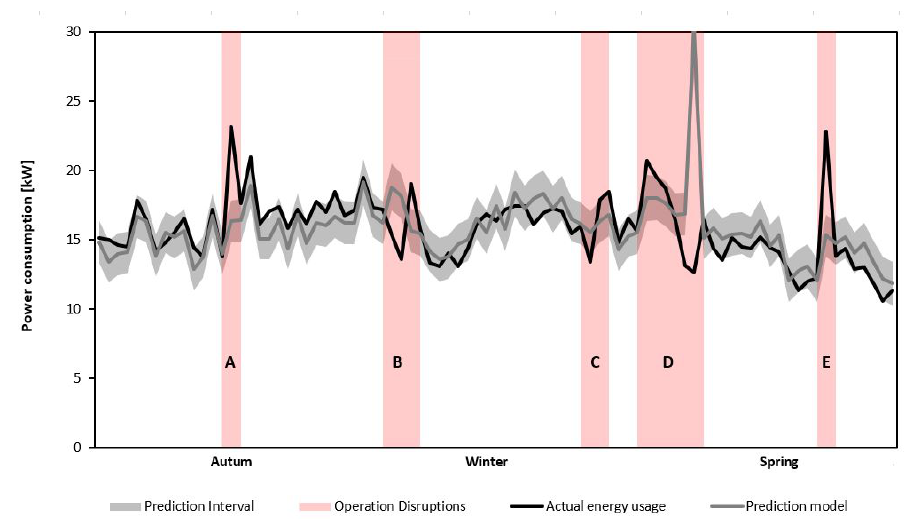
Figure 13. Visual validation of the prediction model from September 2018 to June 2019. The prediction model includes the prediction interval in gray, measured power consumption in black and periods associated with operational disruptions in red (see Appendix A for higher resolution).